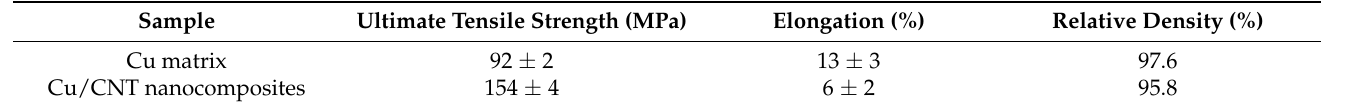
Figure 7. Stress–strain curves of the Cu matrix and Cu/CNT nanocomposite as-sintered samples. Table 1. Tensile strength, elongation, and relative density of the Cu matrix and Cu/CNT nanocom- posite as-sintered samples.